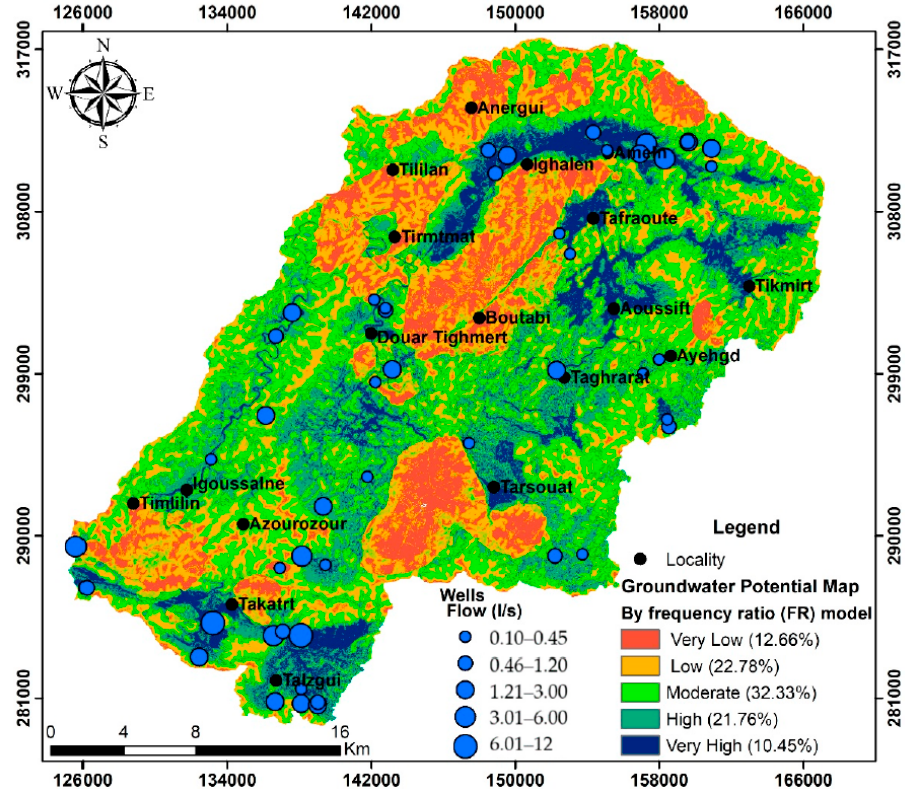
Figure 13. Groundwater potential map by the frequency ratio (FR) model.